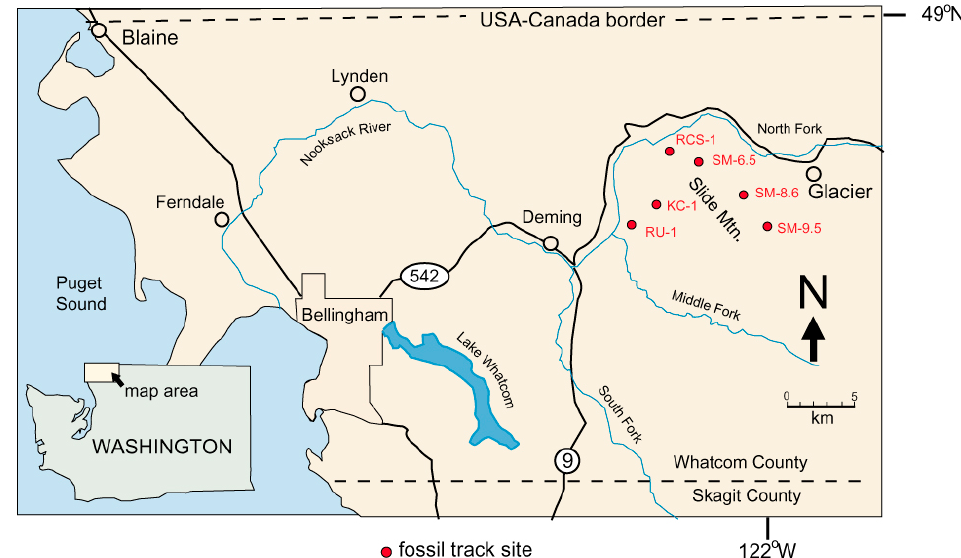
Figure 1. Chuckanut Formation fossil track locations. Reptile trace fossils are known only from Western Washington University (WWU)-KC-1 turtle trackway) and WWU-RCS-1 ( Crocodylian tracks) sites. Table 1. Reptile track locations. GPS locations are from WGS 84 datum. Locality Number Latitude Longitude Elevation (Meters) Location WWU *